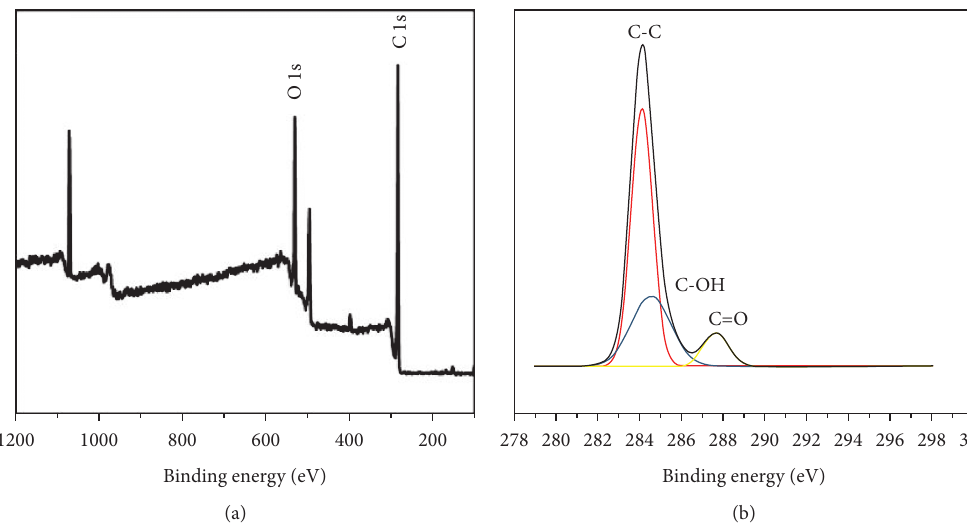
Figure 5: XPS survey (a) and the C 1s core level XPS spectrum of the carbonized aramid fiber